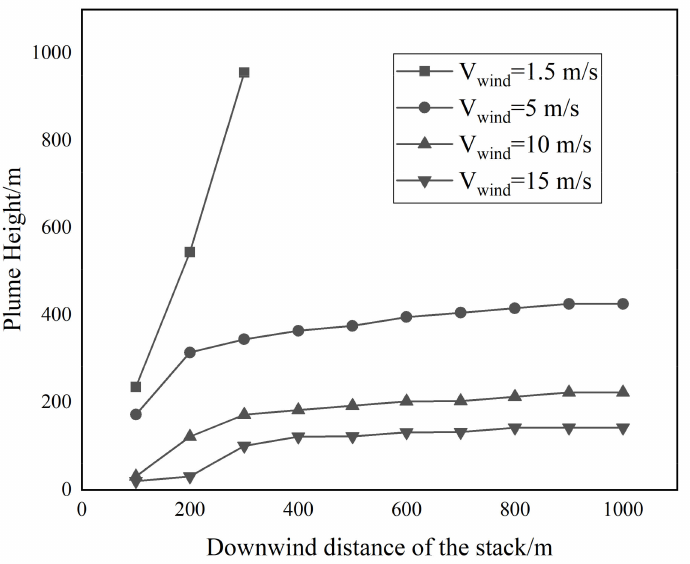
Figure 5. BL1 simulations: Different plume heights at different wind